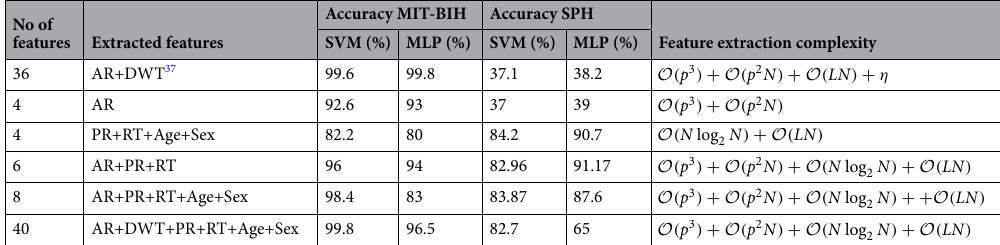
No of features Extracted